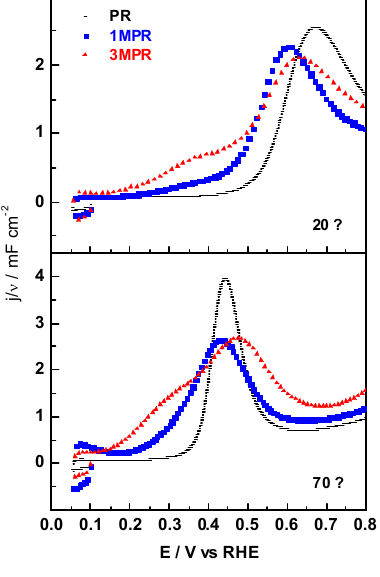
SO . E = 0.1 V, sweep rate = 0.02 V s − 1 . Reprinted 2 4 ad